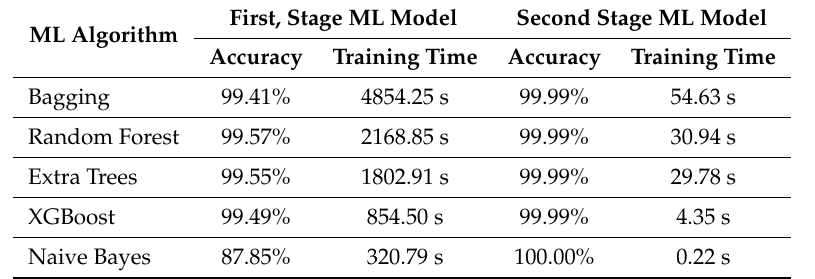
Table 8. Performance of ML algorithms on the training set at each stage.